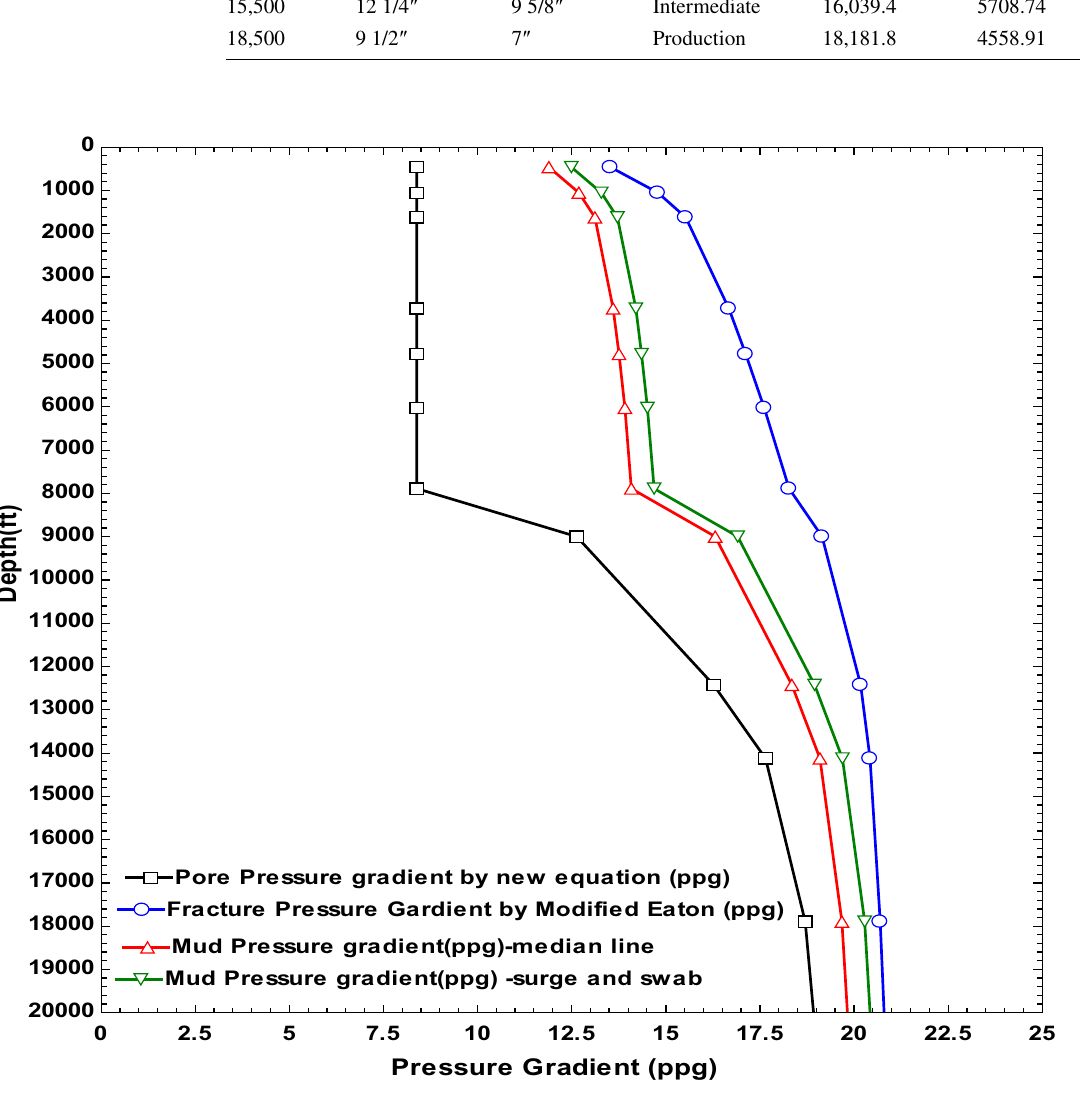
Fig. 11 Optimum mud weight on the top of the Tulamura